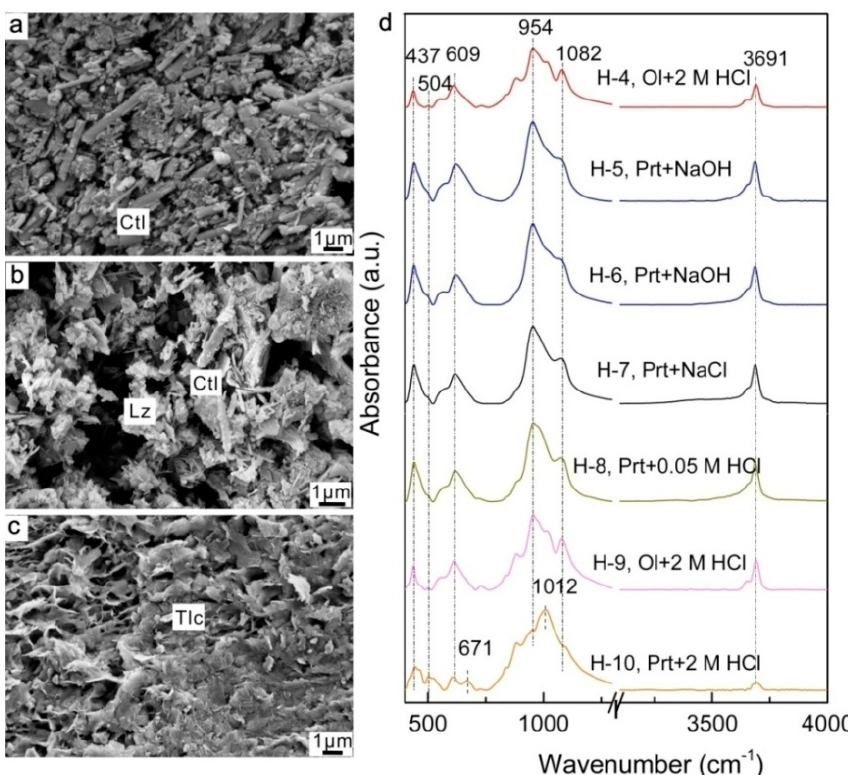
Figure 2. Characterization of the solid experimental products. Scanning electron microscope images of ( a ) H-6, with peridotite and alkaline solutions (0.5 M NaOH, pH = 13.5); ( b ) H-8, with peridotite and acid solutions (0.05 M HCl, pH = 2.50); ( c ) H-10, with peridotite and high acid solutions (2 M HCl) as starting reactants; and ( d ) Infrared spectra of the experimental products. Ctl: chrysotile; Lz: lizardite; Tlc: talc; Prt: peridotite.